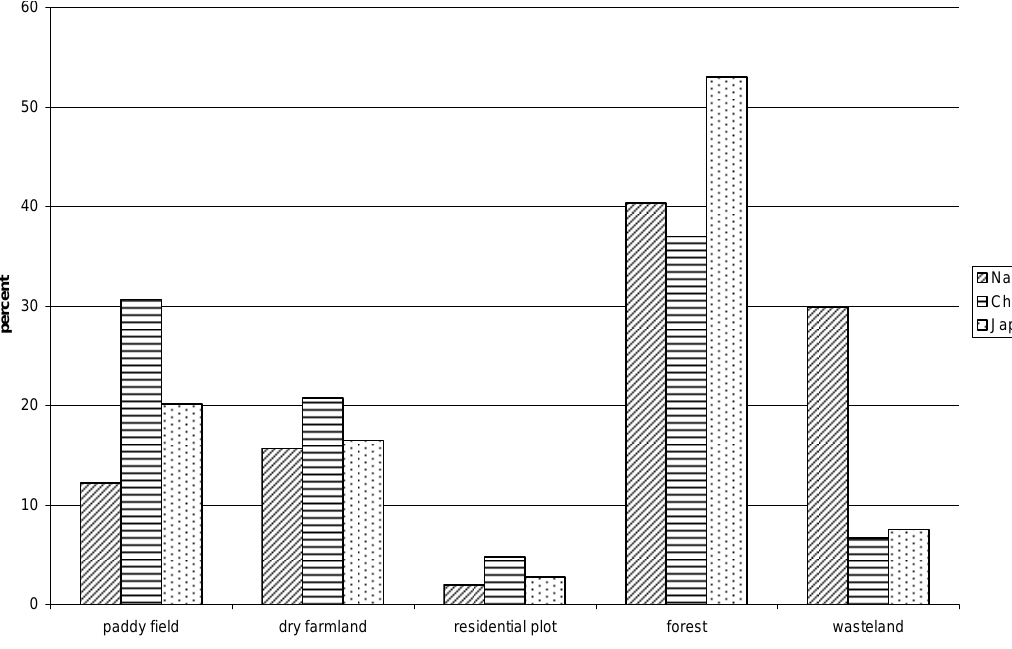
Figure 6. Private Land Usage in Nagano, Chiba and Japan, 1888.